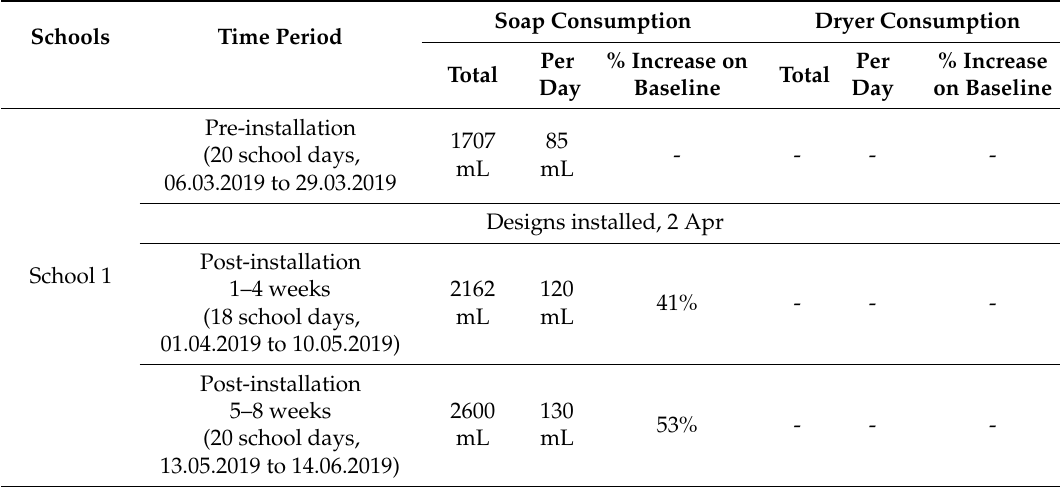
Table 3. School hand hygiene product